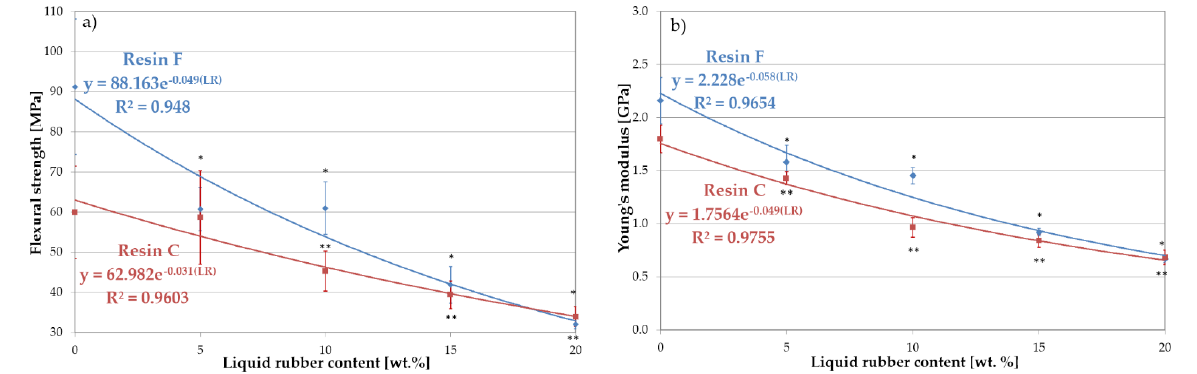
Figure 7. Mechanical properties of resin blends modified with liquid rubber: ( a ) flexural strength and ( b ) Young’s modulus. The symbols (*) and (**) indicate statistically significant differences in relation to the base resin, for resin F and C, respectively.